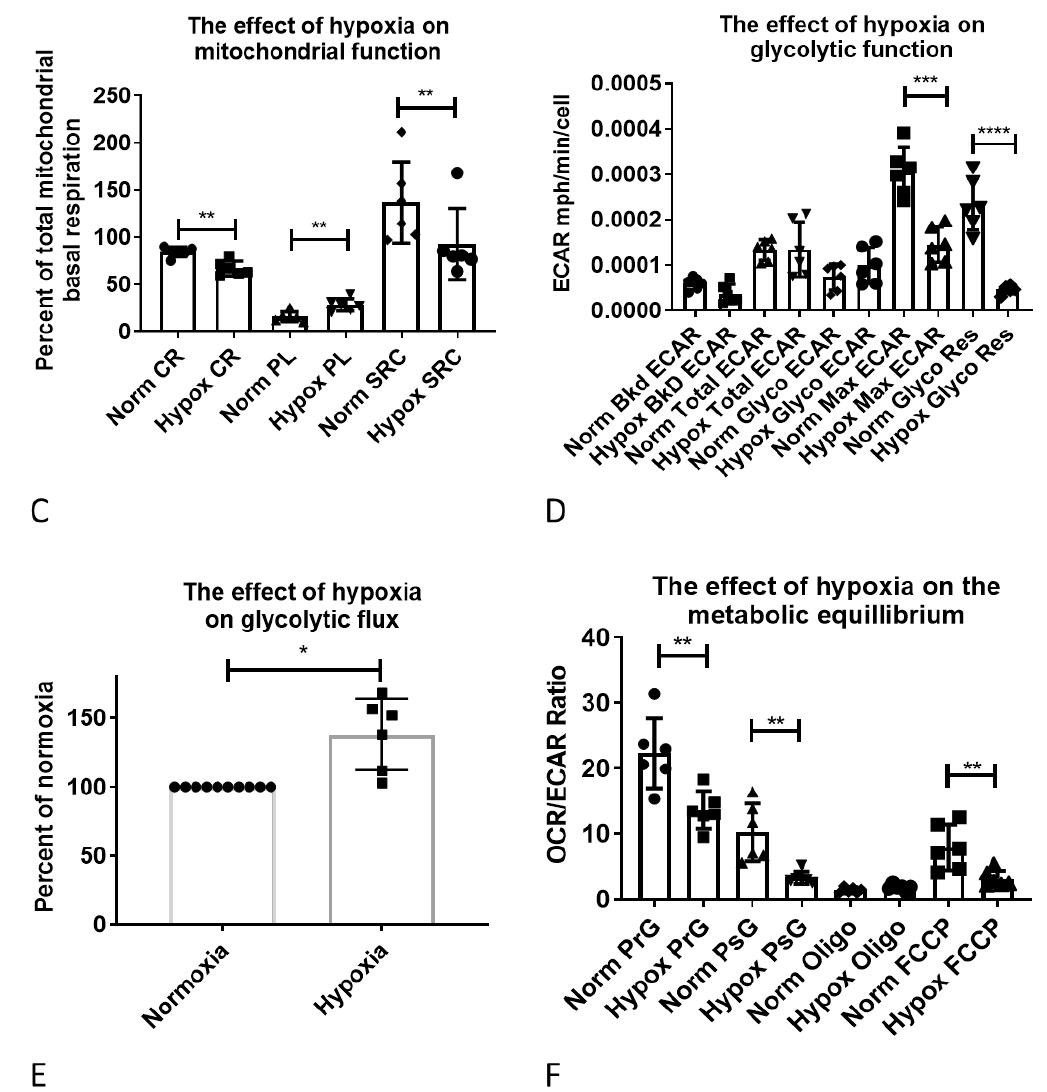
Figure 8. Hypoxia reduces mitochondrial respiratory function and glycolytic capacity under stress. ( A ) Oxygen consumption rate in astrocytes under normoxia and hypoxia; ( B ) The e ff ect of hypoxia on mitochondrial function; ( C ) The e ff ect of hypoxia on mitochondrial function as a percentage of mitochondrial respiration; ( D ) The e ff ect of hypoxia on glycolytic function; ( E ) The e ff ect of hypoxia on glycolytic flux as a percentage of normoxia; ( F ) The e ff ect of hypoxia on astrocyte metabolic equilibrium. Data presented as mean with standard deviation, each shape on the graph represents one biological replicate, which was an average of 9–10 wells of a 24-well plate. All assays were performed in triplicate on two independent astrocyte cell lines. Prior to statistical analysis all percentage data was transformed 1 = 1 / Y and 1 = logit(Y) prior to analysis and all data underwent distribution analysis. Subsequently an unpaired t -test or Mann–Whitney test was performed except for panel ( E ) where a Wilcoxon paired rank analysis was performed. * p ≤ 0.05, ** p ≤ 0.01, *** p ≤ 0.001, **** p ≤ 0.0001. OCR = oxygen consumption rate, ECAR = extracellular acidification rate, PrG = pre glucose, PsG = post glucose, norm = normoxia, Hypox = hypoxia, MR = mitochondrial respiration, PL = proton leak, CR = coupled respiration, SRC = spare respiratory capacity, NG = non-glycolytic, Glyco = glycolytic, Cap = capacity, Res = reserve, Oligo = oligomycin.